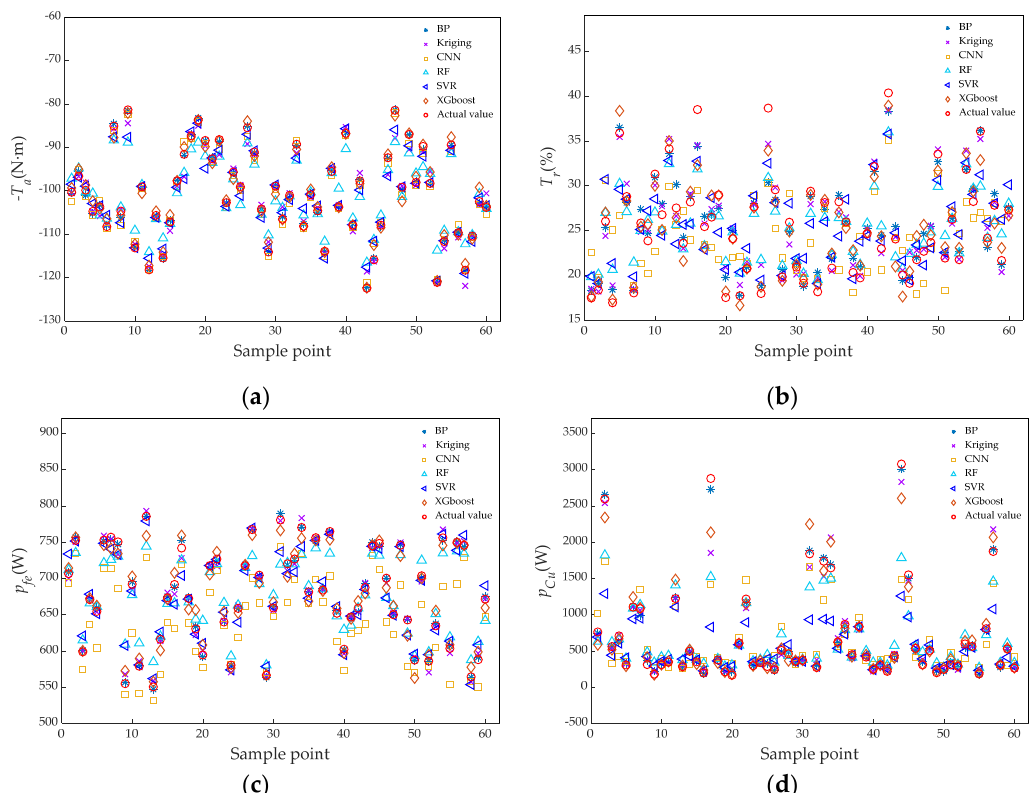
Figure 5. Prediction results of no normalization of sample points: ( a ) test results of − T a ; ( b ) test results of T r ; ( c ) test results of p fe ; ( d ) test results of p Cu . Table 4. Evaluation indicators of each surrogate model.